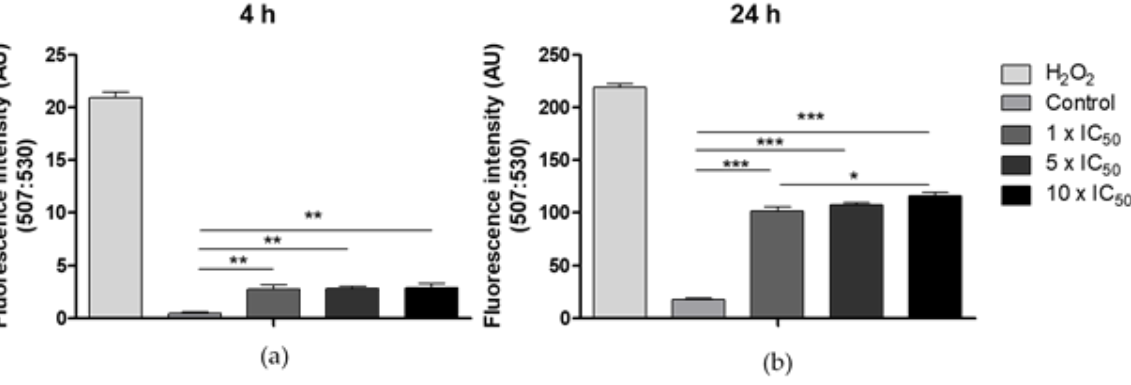
Figure 7. Analysis of ROS generation in epimastigotes, after ( a ) 4 h and ( b ) 24 h treatment with 1 × , 5 × and 10 × the calculated IC 50 value of [V V O(IN-2H)(L2-H)] on trypomastigotes of T. cruzi . The mean and SD are shown for each condition. Three independent experiments were performed. ANOVA test: * = P < 0.05, ** = P < 0.01, *** = P < 0.001.